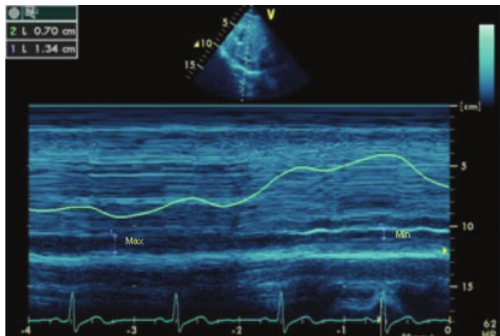
Figure 4: IVC diameter, measured using M-mode from the sub- costal view. The minimum and maximum diameters are used to calculate the IVC distensibility and/or variability index. (Courtesy of A. McLean, S. Huang, and I. Ting, Nepean Critical Care Echo Group, Nepean Hospital, Sydney University, Australia).